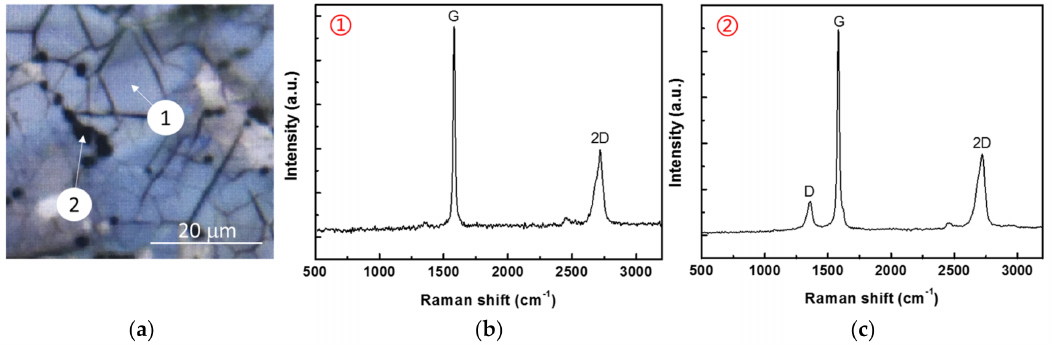
Figure 2. Metallomicroscope image ( a ) of Ni–P–G with corresponding Raman spectra of regions 1 (cid:13) ( b ) and 2 (cid:13) ( c ).